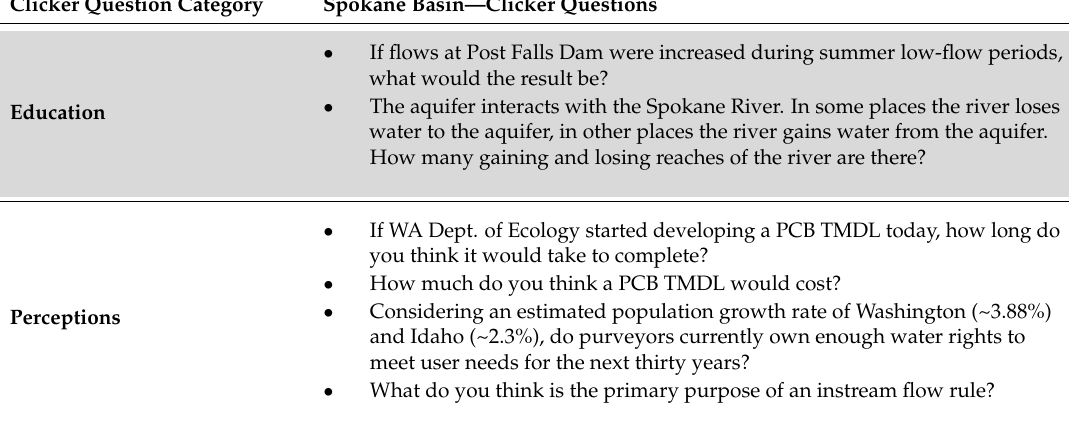
Table 3. Partial list of clicker questions presented to participants at the Spokane River Forum between 2011 and 2014 (for additional questions please contact authors). Multiple-choice answer alternatives to six of these questions and the participant’s responses are listed in Table